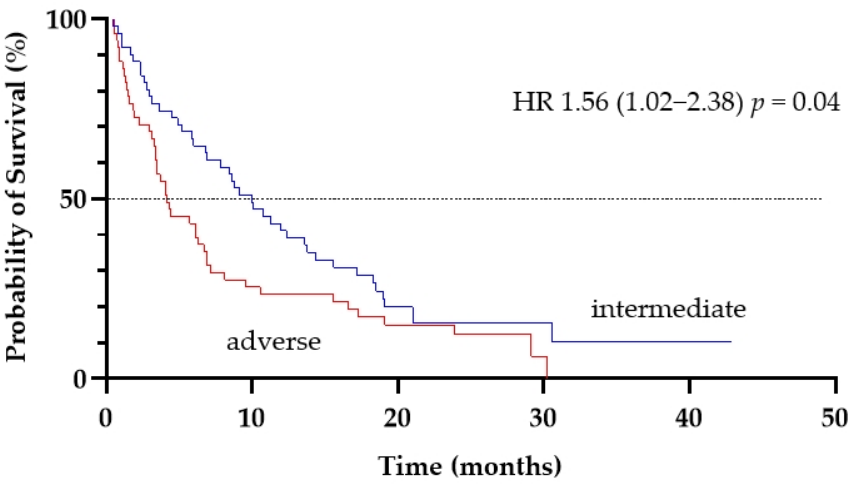
Figure 5. The effect of cytogenetic risk (adverse vs. intermediate) on overall survival of patients treated with LD-AC+cladribine.